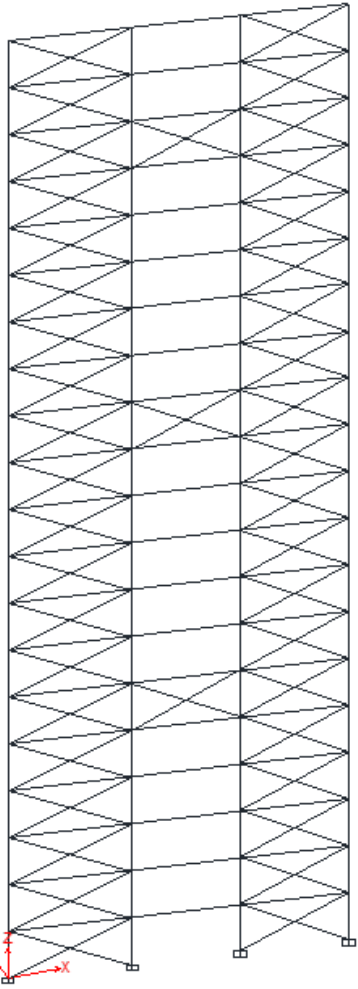
Figure 24. Schematic view of the 20-story model of an undamaged frame in Seismostruct.